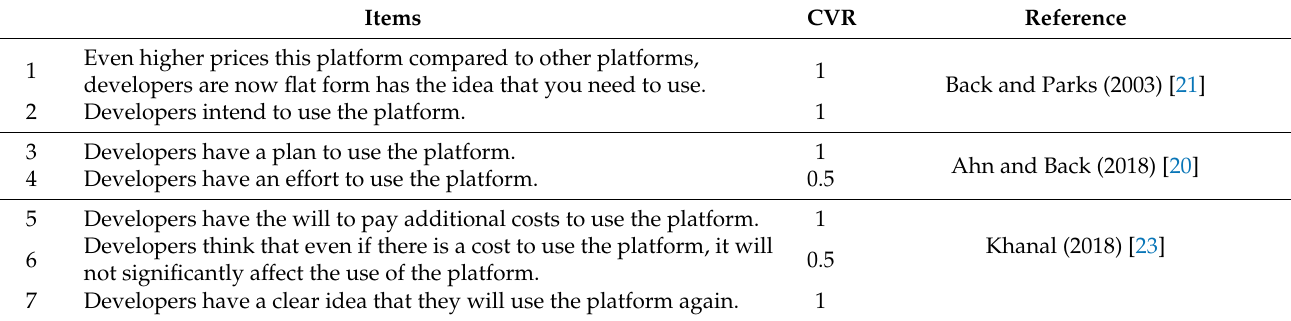
Table 3. Pilot items for the measurement of behavioral factor and calculated